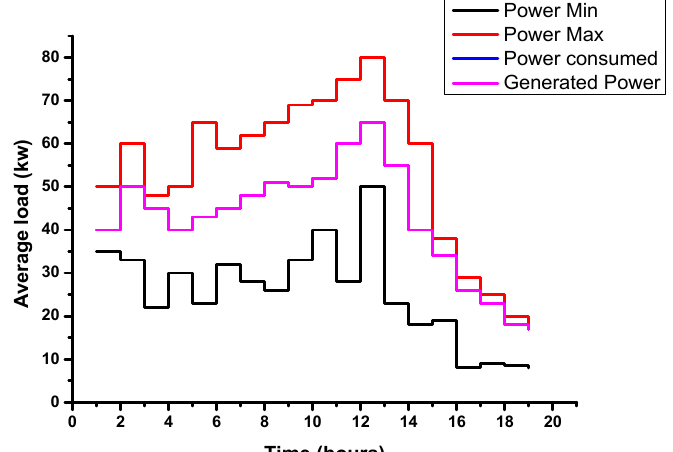
consumers. As expected, both curves relative to the overall energy consumption of the